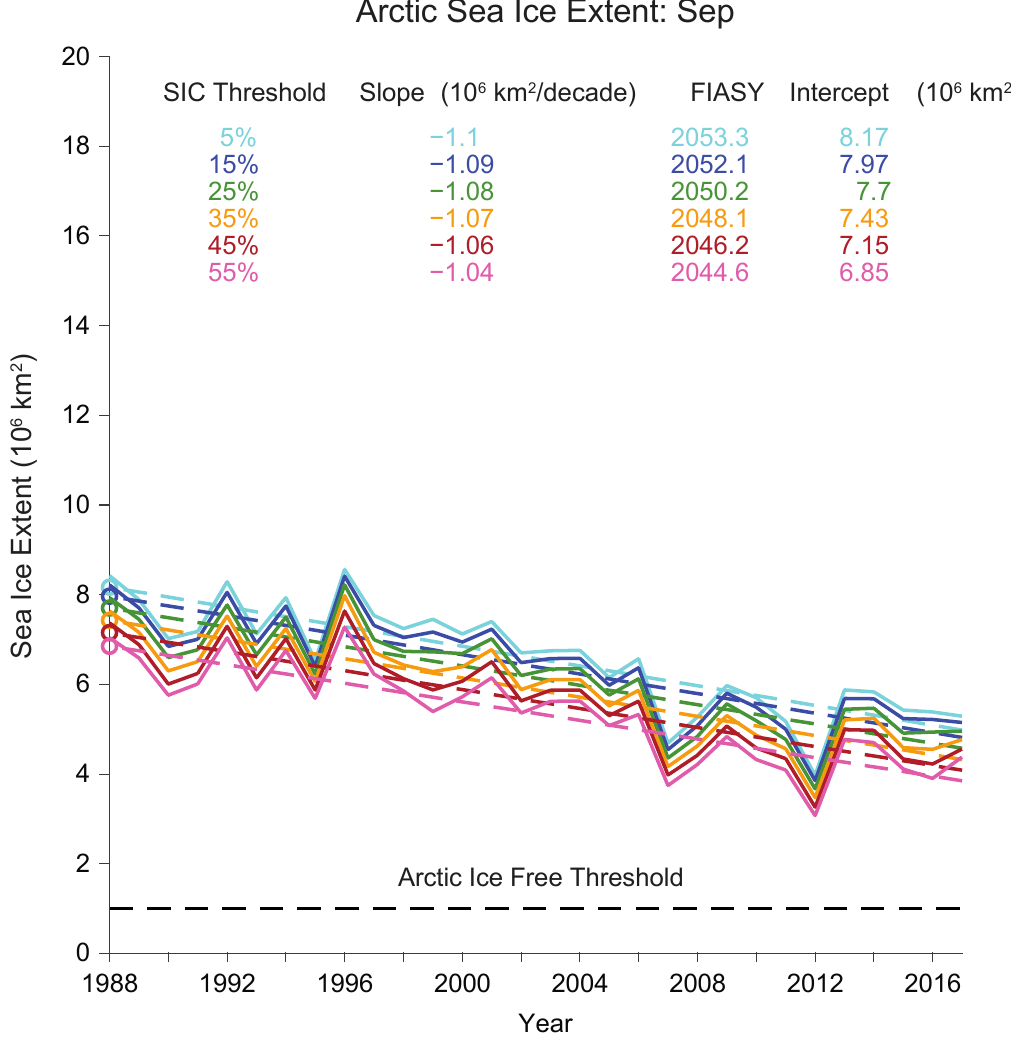
Figure 7. Arctic annual minimum SIE time series (solid) for 1988–2017 and their linear regressions (dashed) for varying SIC thresholds. The circles represent the initial positions (the 1988 value of the trend line) of the linear regression (Intercept).